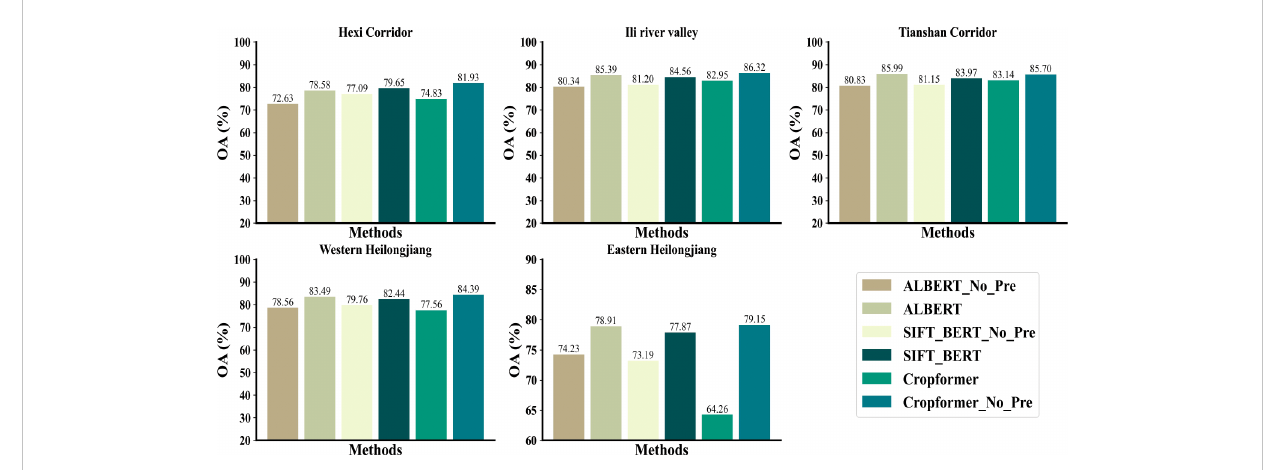
FIGURE 7 Performance comparison of Cropformer and other classi fi ers in fi ve study